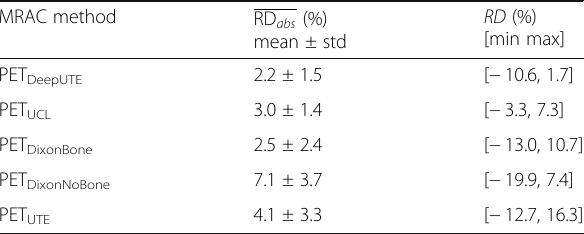
Table 2 The mean absolute relative difference ( RD abs ) and the range of RD in 18 F[FDG] uptake for the PET MRAC methods compared to PET CTAC .